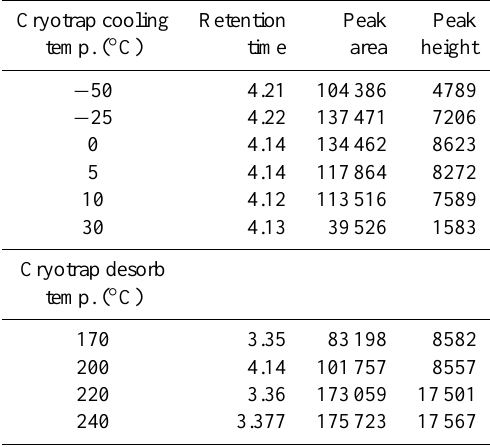
samples, was 90 pg. The detection limit in scan mode was 300